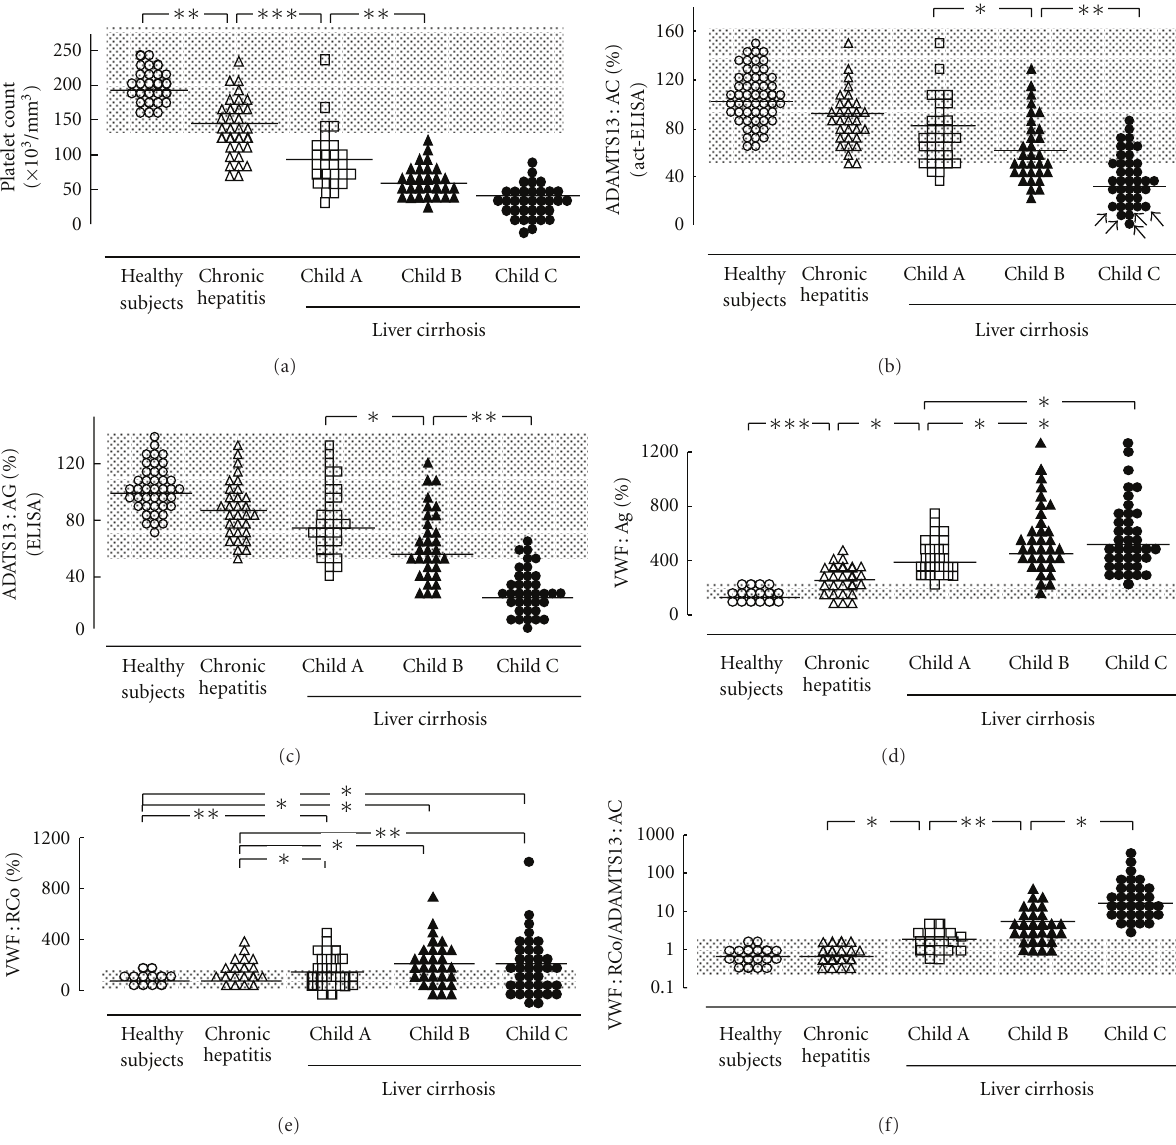
Figure 2: Platelet counts and plasma levels of ADAMTS13:AC and its related parameters in patients with chronic liver diseases. Platelet counts decreased with the severity of chronic liver diseases, but no di ff erence was found between Child B and C (a). Plasma ADAMTS13:AC determined by ELISA progressively decreased with worsening cirrhosis (b). Arrows indicate patients whose plasma ADAMTS13:AC was extremely low ( < 3% of normal control by VWFM assay). The ADAMTS13:AG levels determined by ELISA also decreased with increasing cirrhosis severity (c), which highly correlated with ADAMTS13:AC measured by the act-ELISA ( r = 0 . 715, P < . 001). The VWF :Ag increased with the progression of chronic liver diseases, but the di ff erence between Child B and C did not reach statistical significance (d). The VWF:RCo is higher in liver cirrhosis patients than that in patients with chronic hepatitis and healthy subjects, but it did not di ff er among subgroups within liver cirrhosis (e). The VWF:RCo relative to ADAMTS13:AC progressively increased with worsening chronic liver disease (f). Open circles: normal controls; open triangles: chronic hepatitis; open squares: cirrhosis with Child A; closed triangles: cirrhosis with Child B; closed circles: cirrhosis with Child C. Shaded area shows normal range. ADAMTS13:AC:ADAMTS13 activity, ADAMTS13: AG = ADAMTS13 antigen. VWF:Ag = von Willebrand factor antigen, VWF: RCo = von Willebrand factor ristocetin cofactor activity; ∗ P < . 05, ∗∗ P < . 01, and ∗∗∗ P < . 001 significantly di ff erent between the two groups. (Partially modified from Uemura et al.,